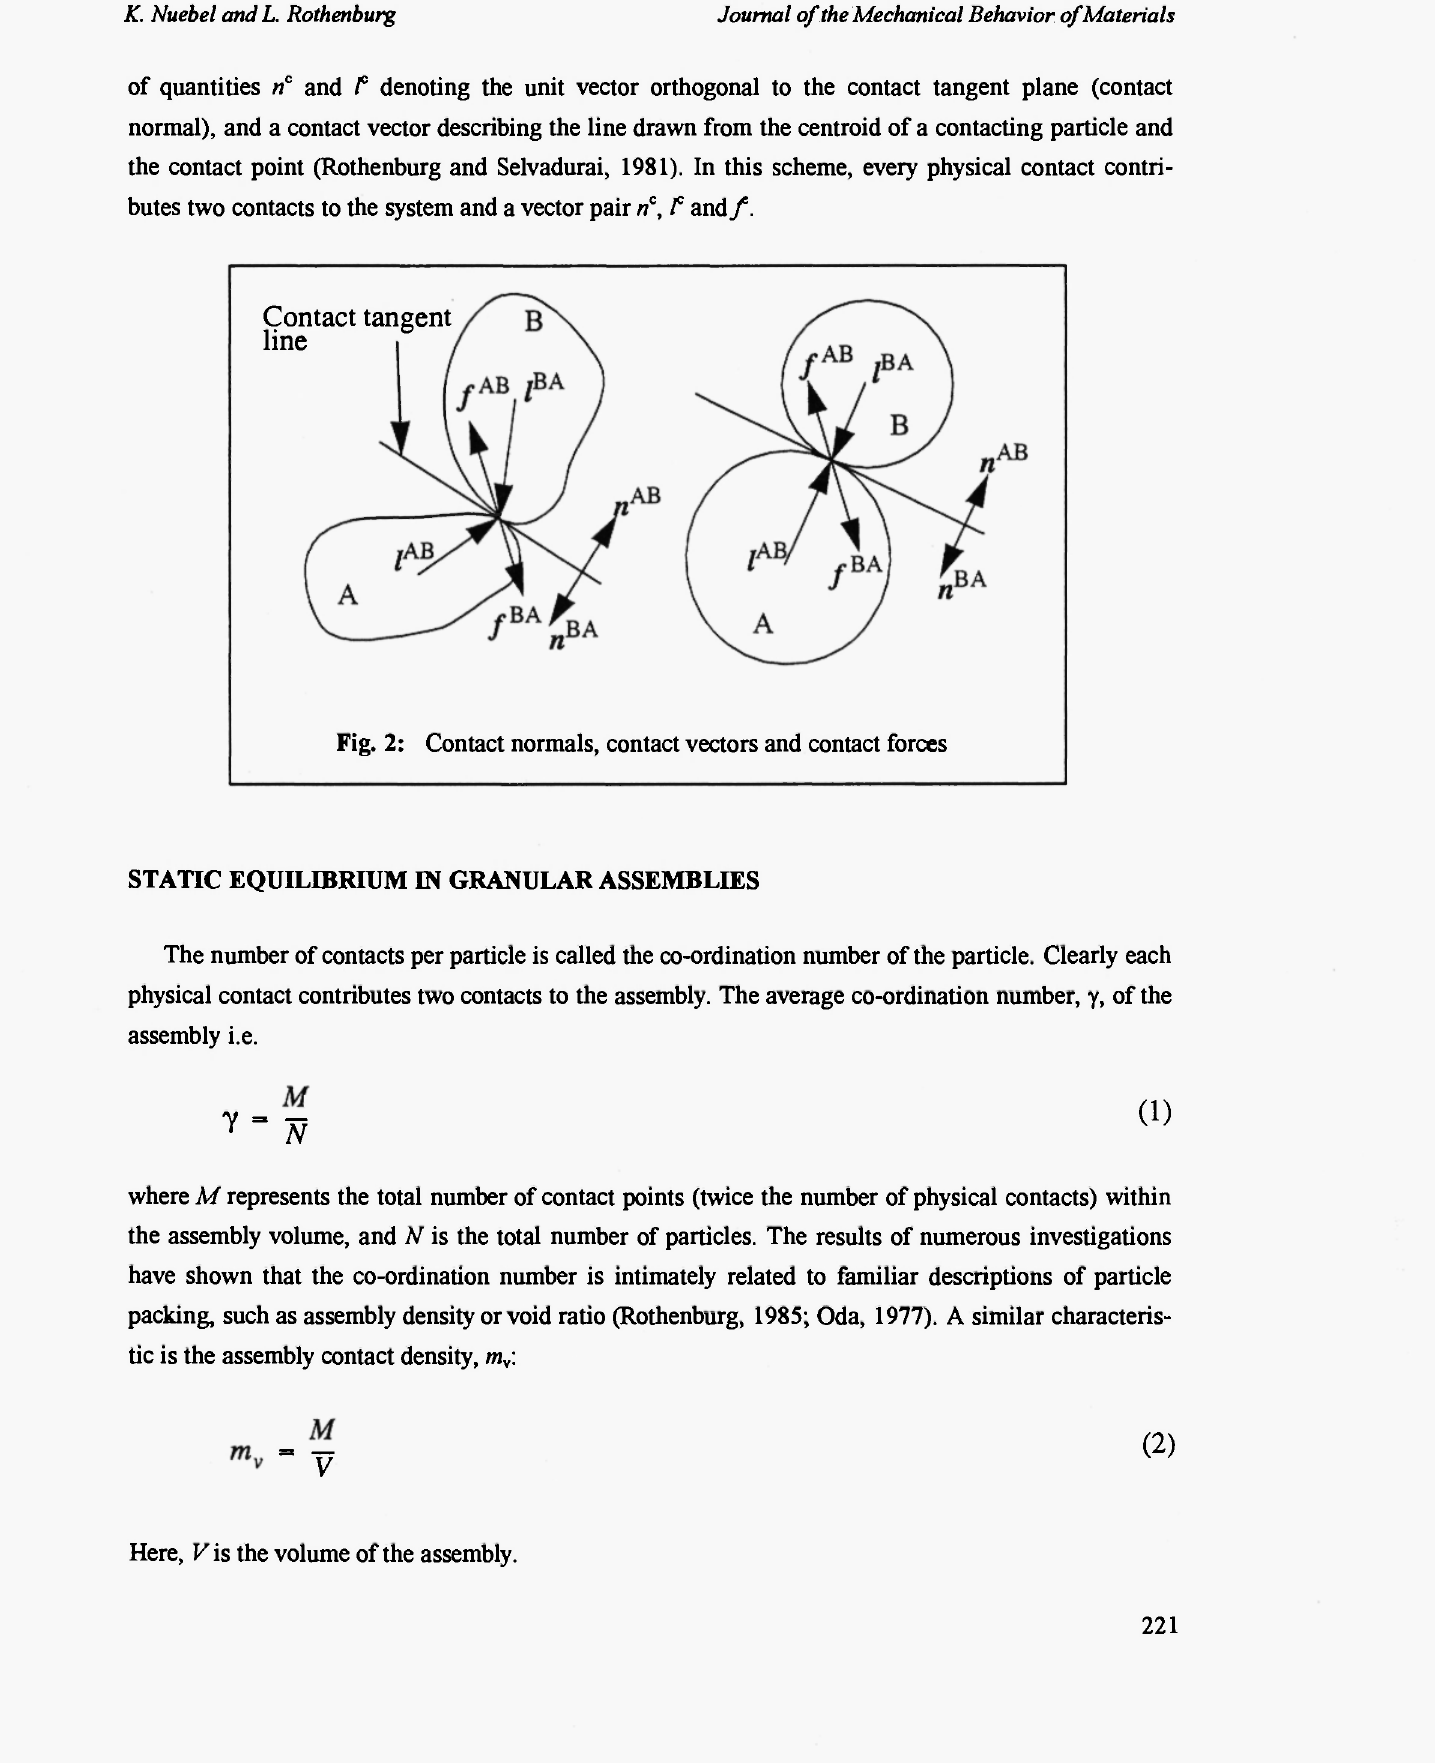
Fig. 2: Contact normals, contact vectors and contact